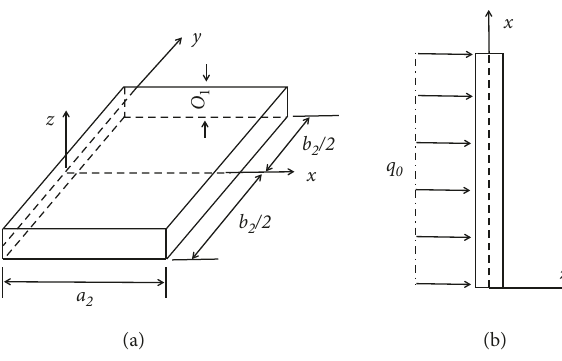
Figure 3: Diagram of force acting on the rectangular bottom plate under frost heaving